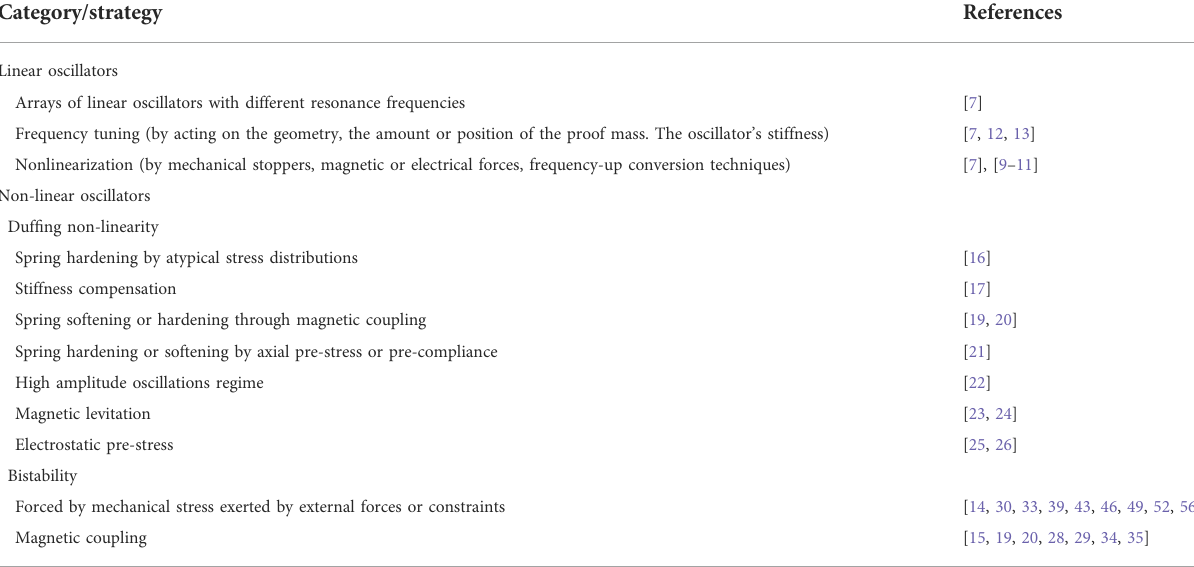
TABLE 7Strategiesto overcomelimitationsof linear oscillators and non-linearprinciplesused in vibrational Energy Harvesting reportedin this work.